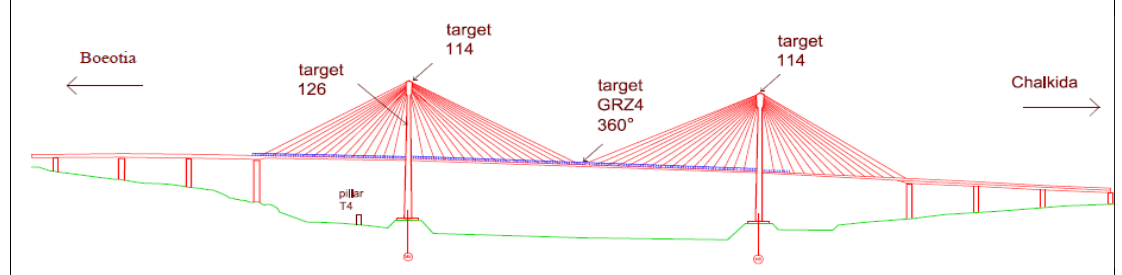
Figure 9. The Evripos Bridge and the monitoring locations.